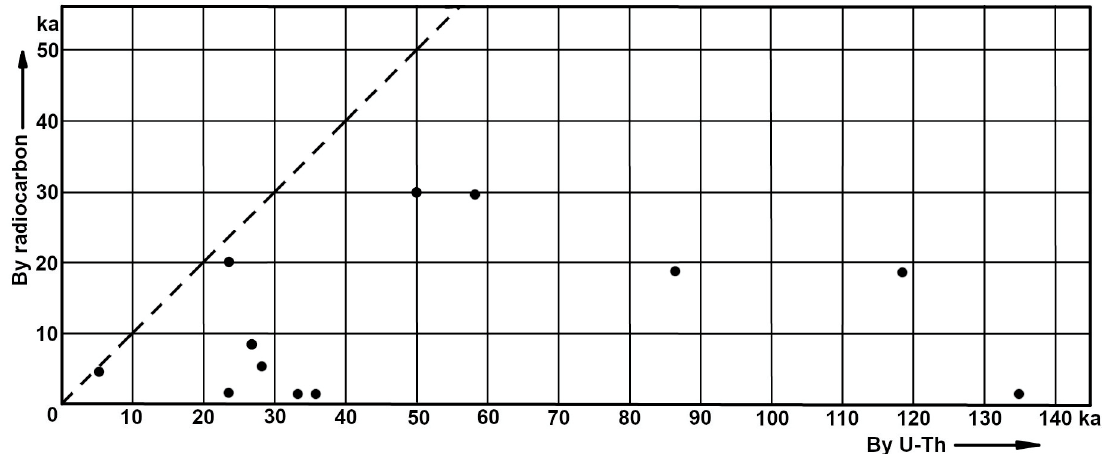
Figure 2. U–Th age determinations of speleothems compared with archaeologically realistic or radiocarbon ages of these same deposits.